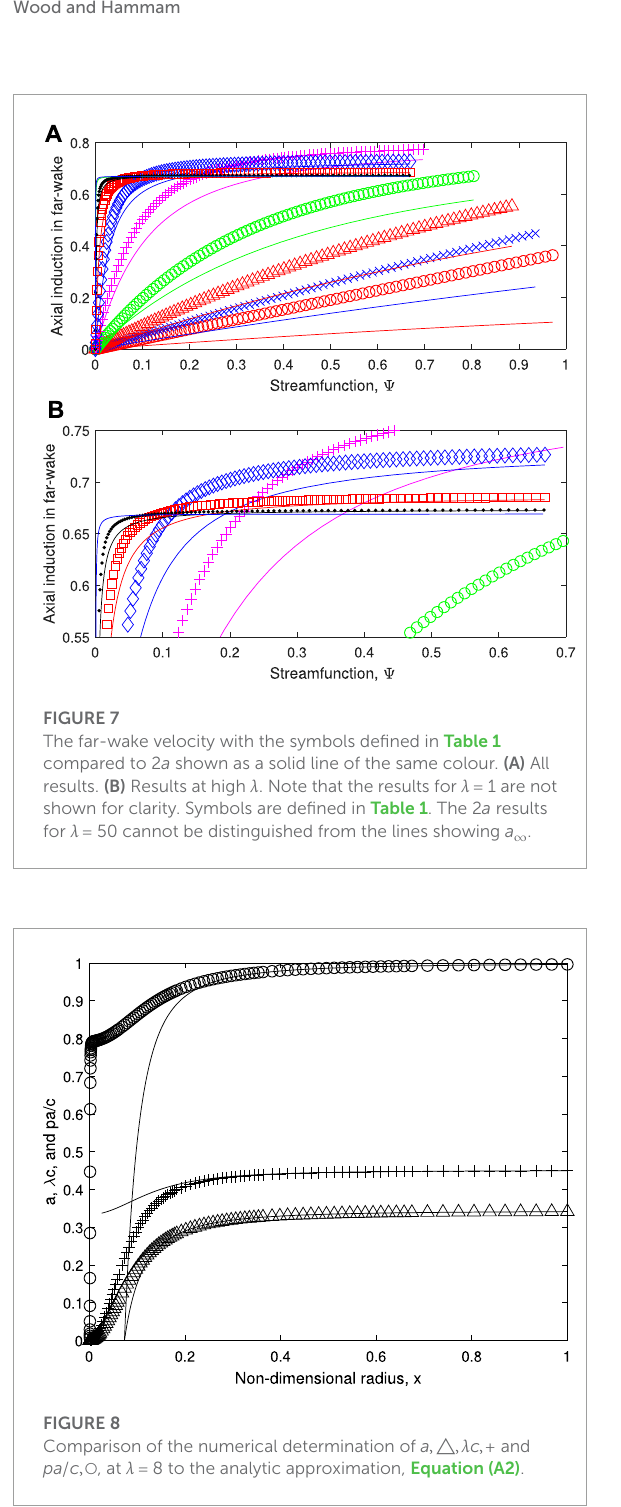
from Figure 7 . In the far-wake, ∂v / ∂z = 0 ∀ λ , so the coincidence of vortex lines and streamlines implies that p is constant across the wake as helical symmetry must hold. This result does not avoid the need for CoV because it is insufficient to establish optimality.